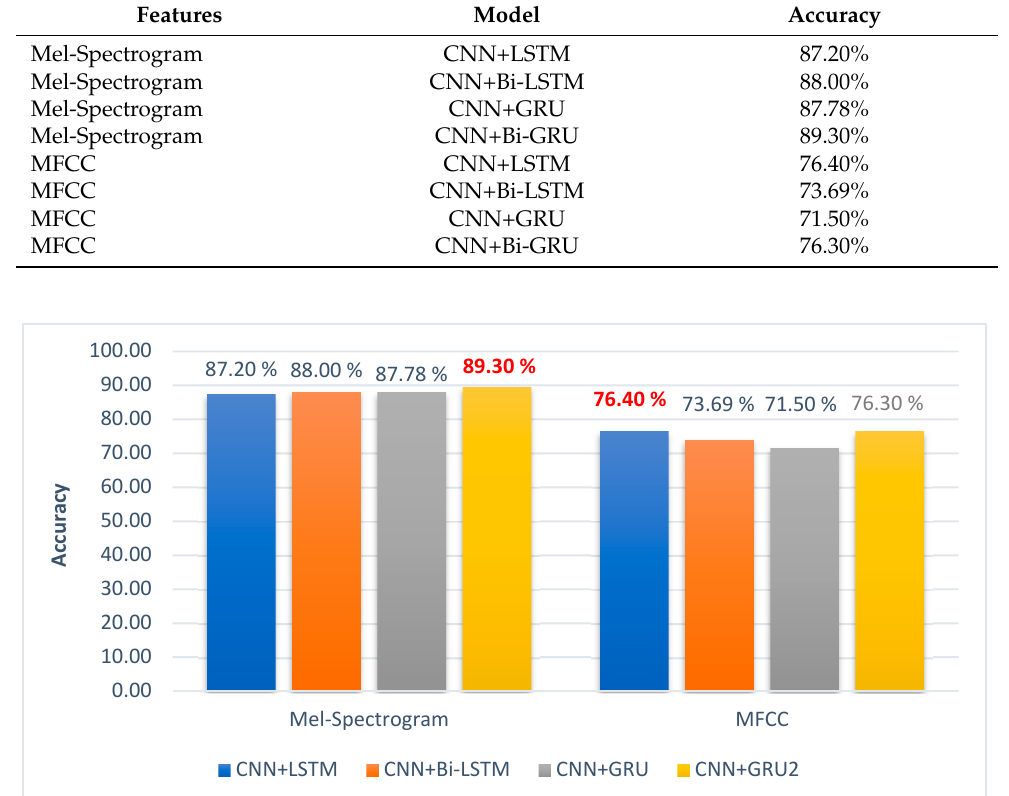
Figure 10. Results of extracted features with the proposed hybrid architecture.